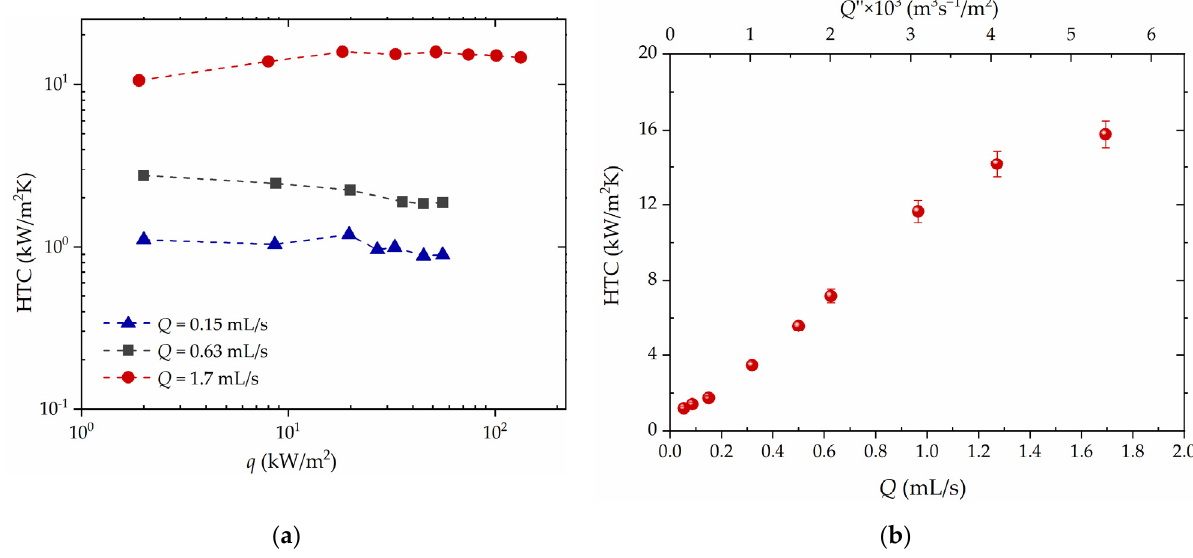
Figure 9. The dependence of the heat transfer coefficient during spray cooling on ( a ) heat flux density and ( b ) liquid flow rate.